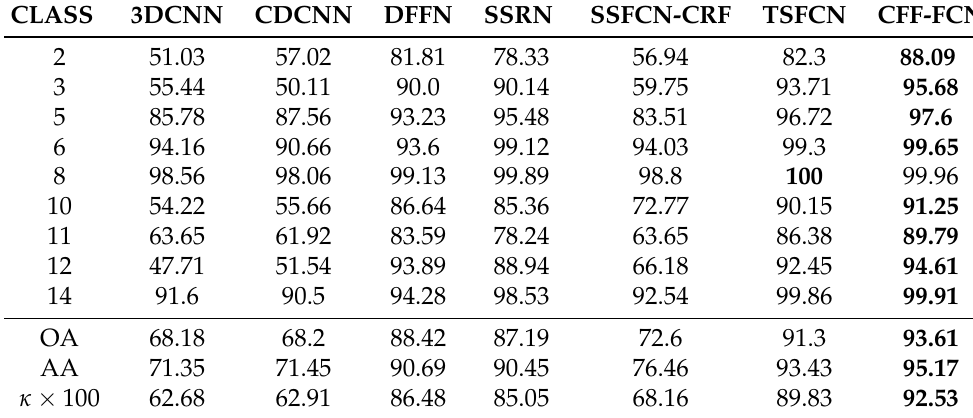
Figure 6. For Indian Pines image. ( a ) RGB composite image of three bands. ( b ) Ground-truth map. ( c ) 3DCNN. ( d ) CDCNN. ( e ) DFFN. ( f ) SSRN. ( g ) SSFCN-CRF. ( h ) TSFCN. ( i ) CFF-FCN. Table 3. Classification accuracy(%) for Indian Pines using different